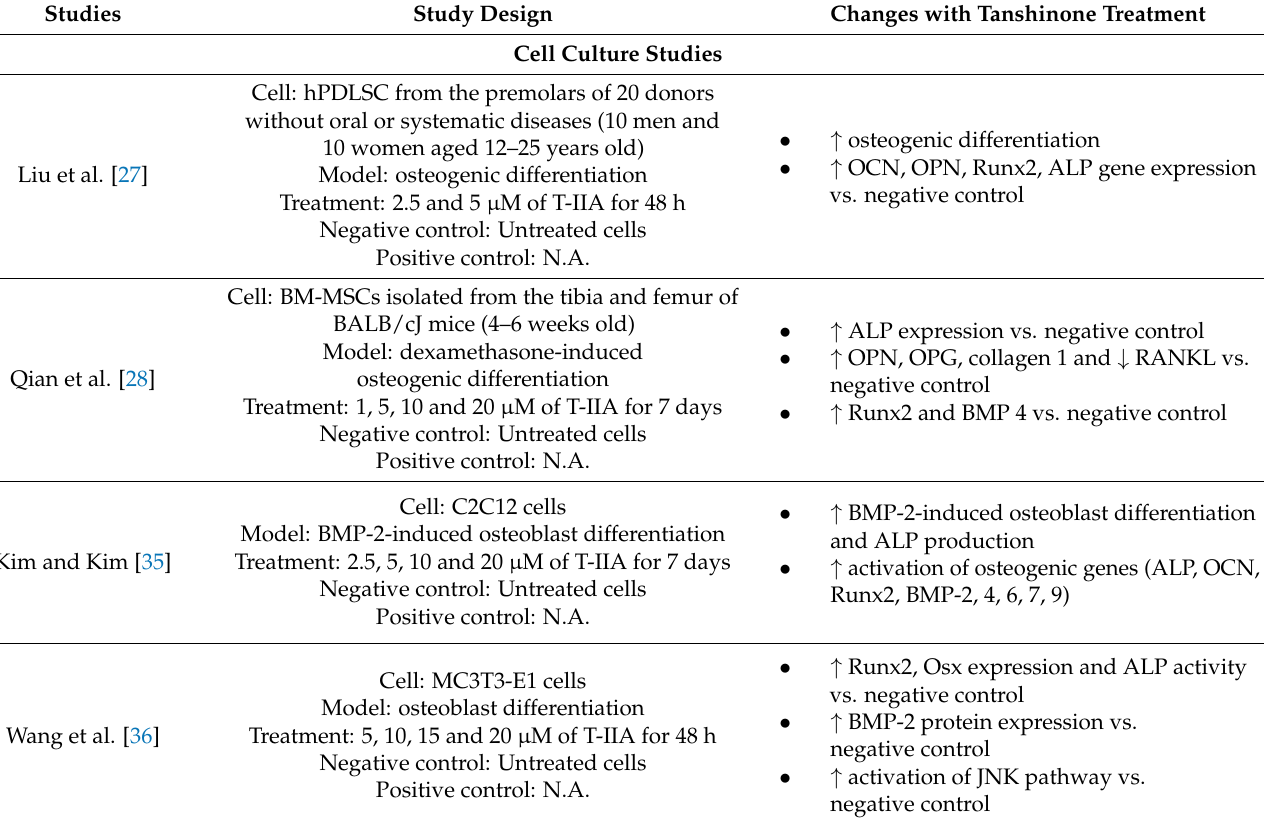
Table 1. Effects of tanshinone on bone